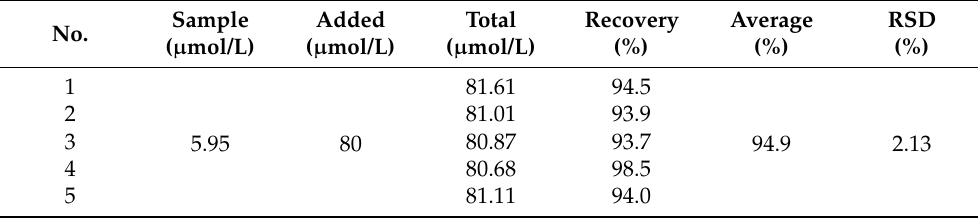
Table 3. MTX standard recovery ( n =